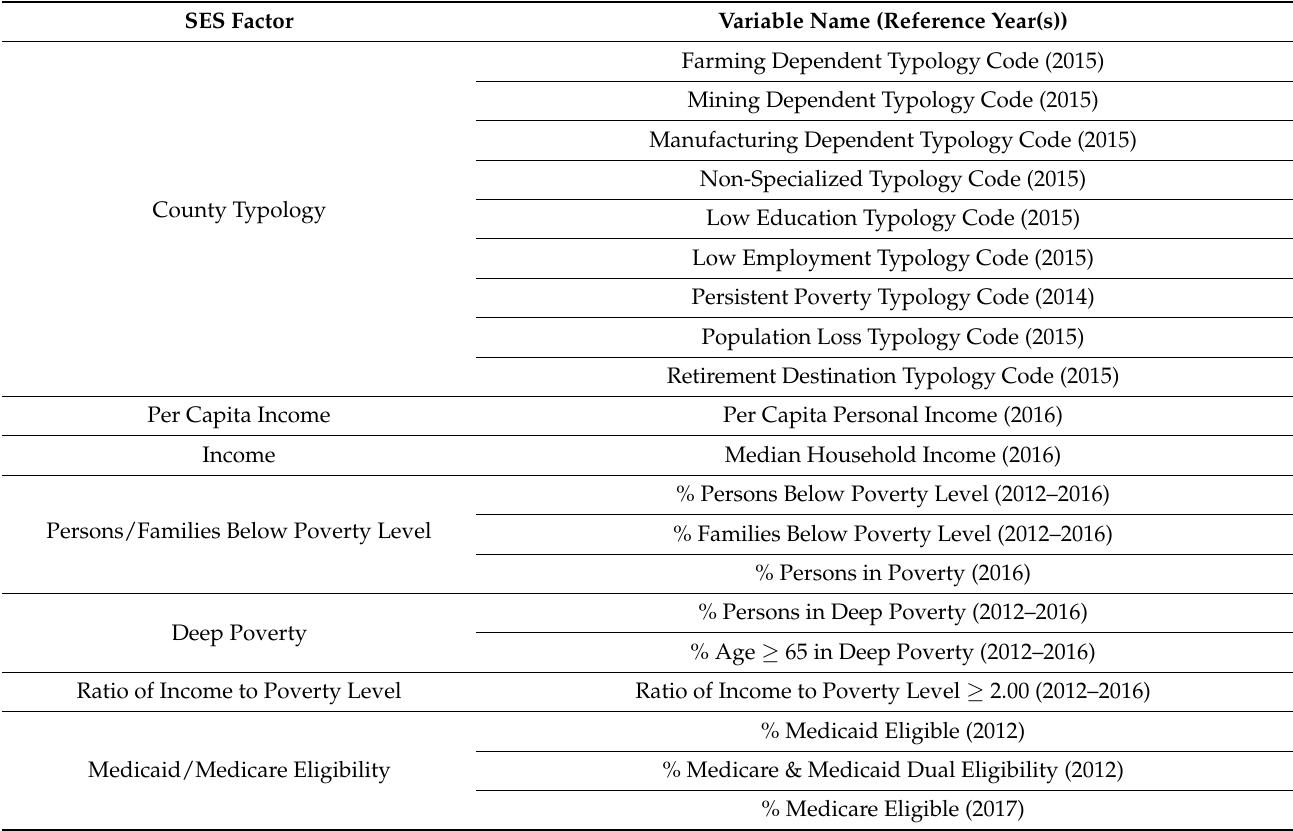
Table 1. List of socioeconomic status (SES) factors selected for the